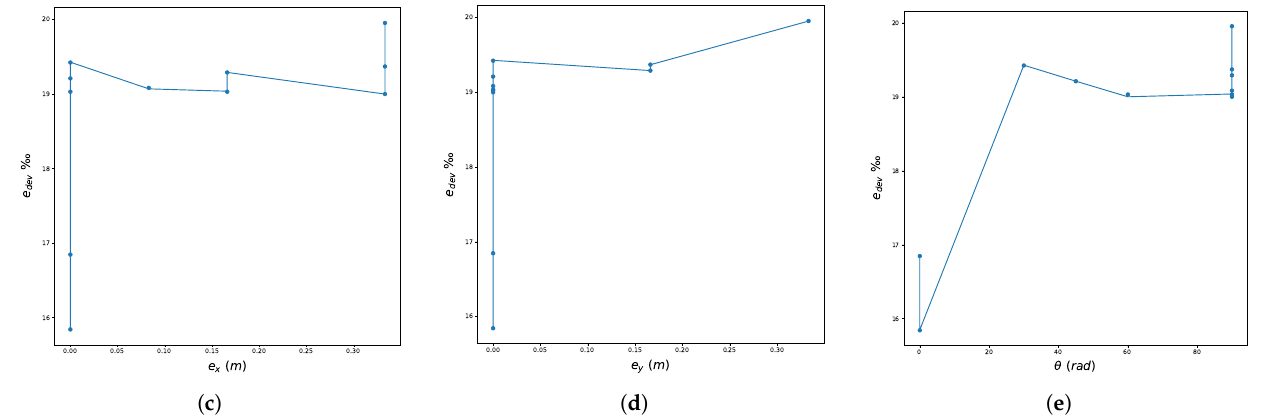
Figure 14. Graphical presentation of the Neural Network that corresponds to Monte Carlo analysis S - κ L - c D -d4 (NND4) for the estimation of the deviatoric component of the strain e dev . ( a ) 3D represen- tation of the Neural Network; ( b ) Epochs-Loss diagram; ( c ) Neural Network representation in the projection to the input axis of e x ; ( d ) Neural Network representation in the projection to the input axis of e y ; ( e ) Neural Network representation in the projection to the input axis of θ